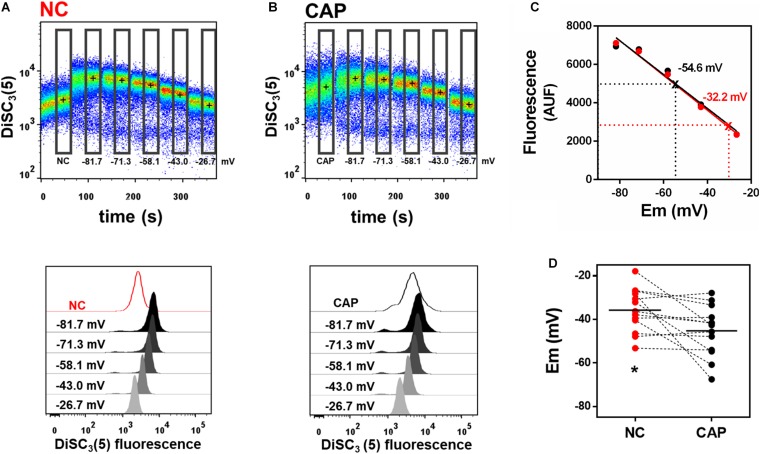
Incubation in capacitating media hyperpolarizes human sperm. (A,B) Upper panel: Representative dot plot of DiSC3(5) fluorescence traces from human donor sperm incubated in non-capacitated (A, “NC”) or capacitating (B, “CAP”) HTF media. Black crosses indicate the median DiSC3(5) fluorescence of sperm within the gates (rectangles) defined for each addition. Calibration was performed as in Figure 1 with 1 μM valinomycin and sequential additions of KCl, corresponding to the theoretical plasma membrane potential values of –81.7, –71.3, –58.1, –43.0, and –26.7 mV. Lower panels: Histograms of DiSC3(5) fluorescence from selected gates as indicated in flow cytometry dot plots above. (C) Linear regression of the calibration curves built from the median fluorescence from NC and CAP sperm obtained in panels A,B. Interpolated values for each curve are indicated. NC r2 = 0.9670, CAP r2 = 0.9860. (D) Sperm membrane potential values in both NC and CAP media were obtained by linearly interpolating the theoretical membrane potential values versus arbitrary units of fluorescence of each trace. Dashed lines connect the same samples incubated in NC and CAP media. ∗P = 0.0212 by paired t-test.